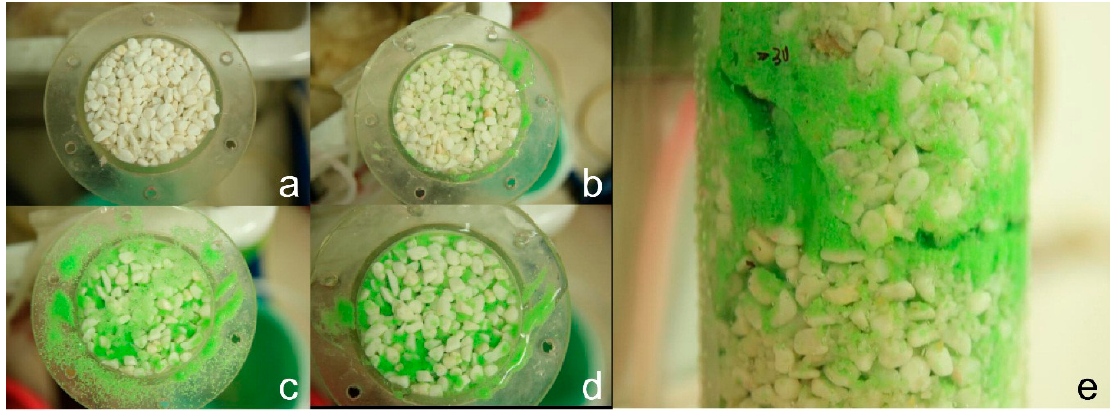
Figure 6. Experimental result: ( a ) 0 min, ( b ) 60 min, ( c ) 90 min, ( d ) 150 min, and ( e ) 210 min.